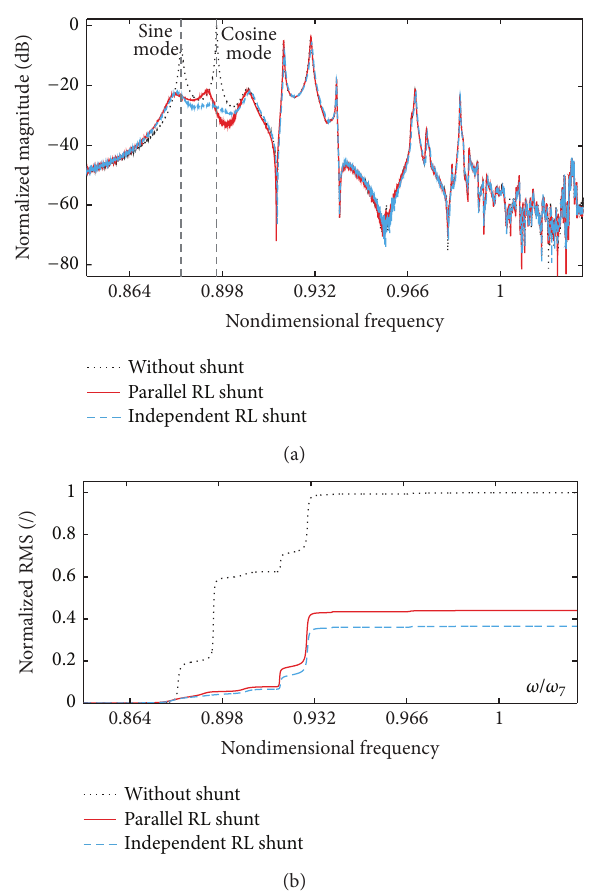
Figure 18: (a) Experimental normalized FRF 𝑇(𝜔) = | ̇𝑥/𝜂| between the appropriate excitation and the response of blade #52 for various tuning conditions of the RL shunt. (b) Cumulative RMS response 𝜎(𝜔)